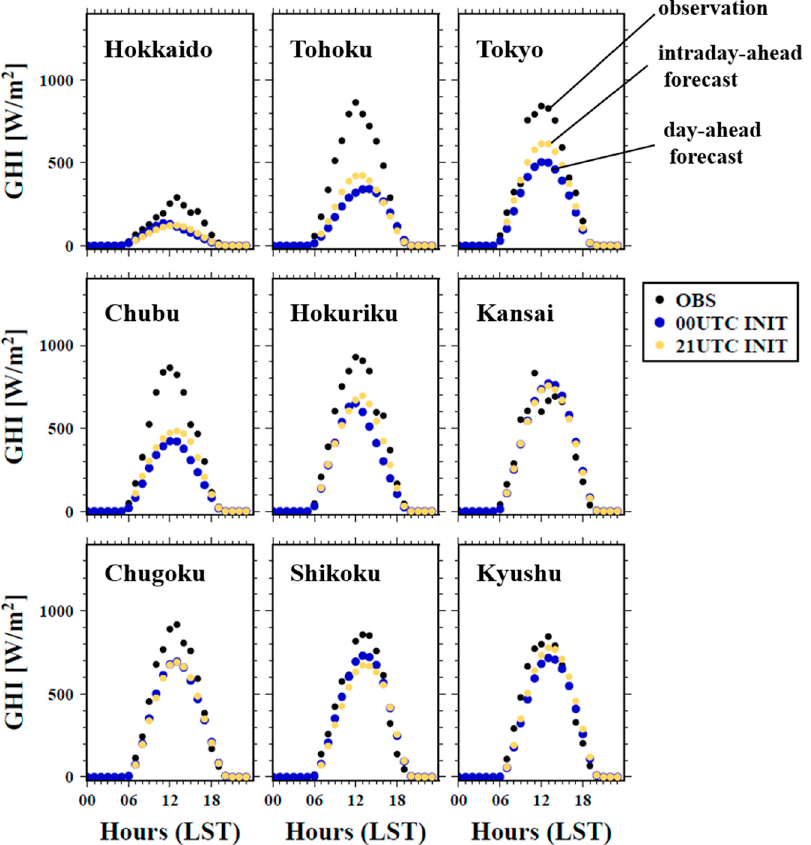
Figure 10. Same as Figure 4, but for 29 July 2016.